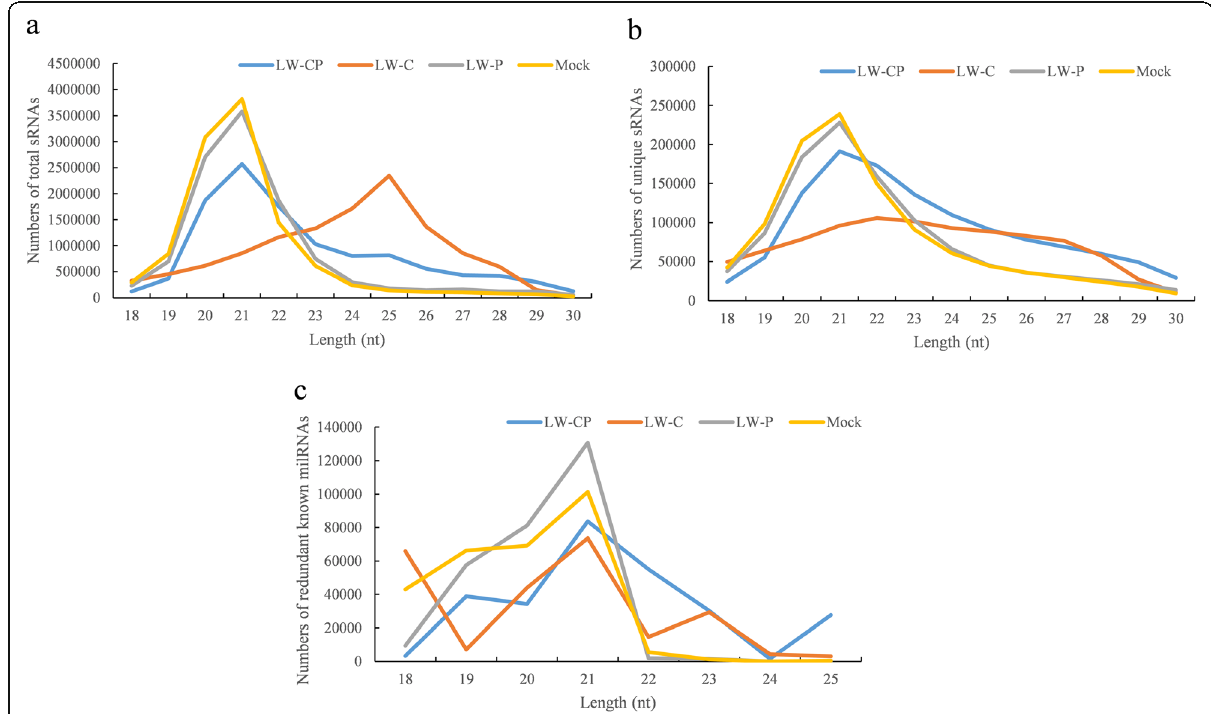
Fig. 8 Length distribution of small RNAs (18 – 30 nucleotides) in the four libraries Botryosphaeria dothidea LW-Hubei strains. a Total small RNAs; b unique small RNAs; and c known